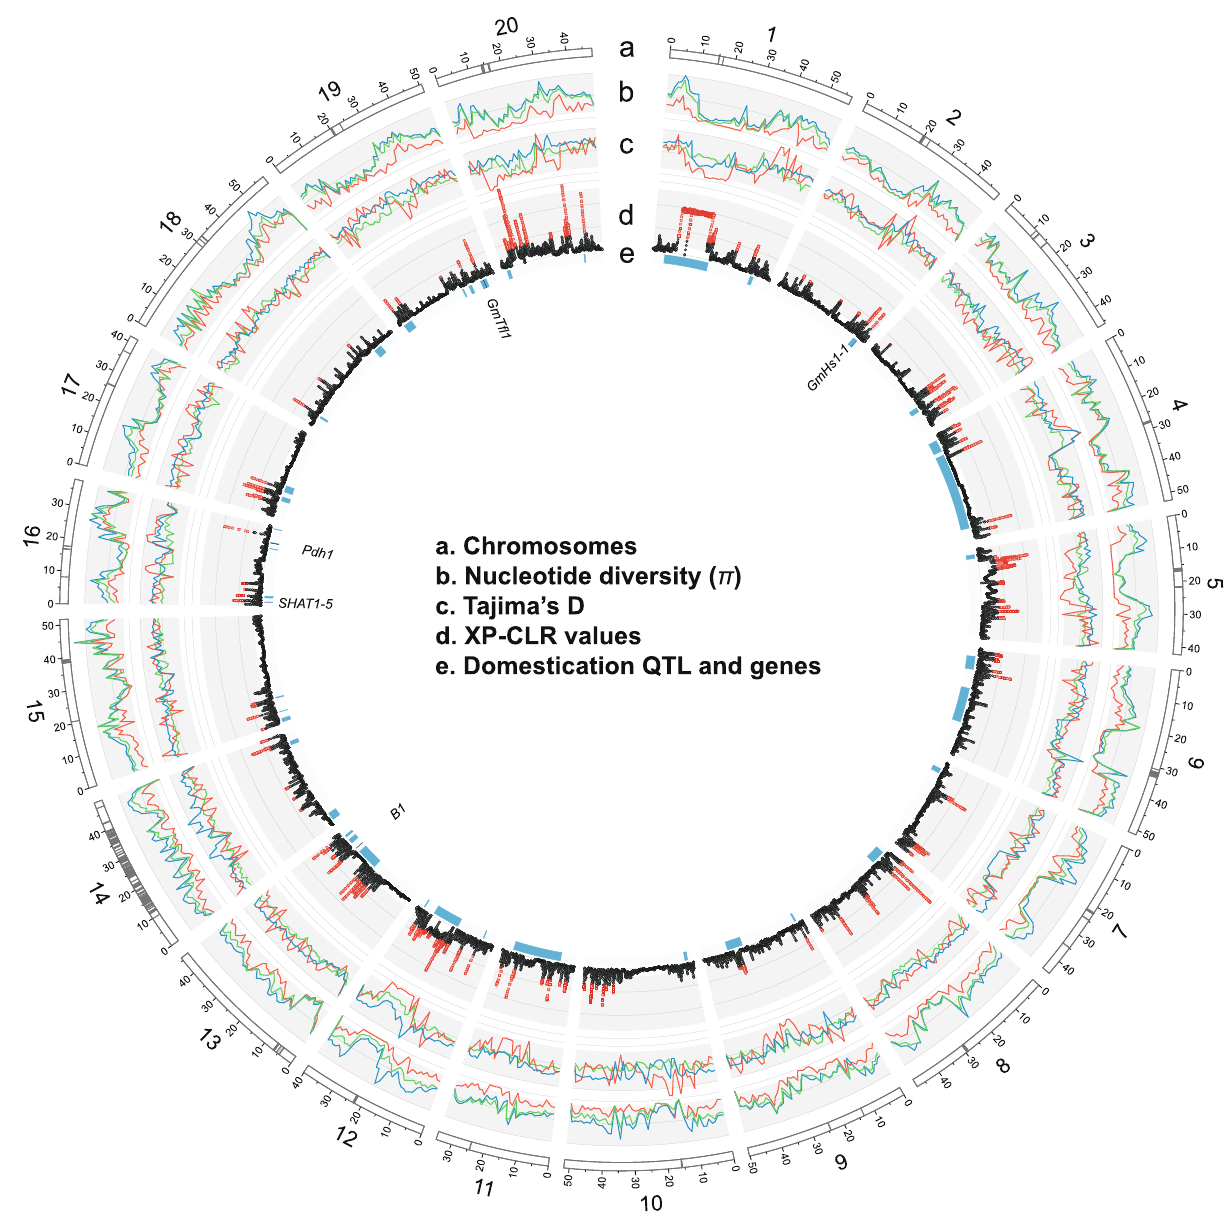
Fig. 3 Genomic landscape of selection signals for domestication in soybean. Chromosomes based on the Williams 82 reference genome sequence v. Wm82.a2.v1 (a). Centromere repeat regions are indicated by gray bands. Nucleotide diversity ( π ) in 1 Mb windows for each soybean subpopulation (red = G. max , dark blue = G. soja , green = hybrid) (b). Tajima ’ s D for each soybean subpopulation (red = G. max , dark blue = G. soja , green = hybrid) (c). Distribution of genome-wide likelihood (XP-CLR) values for selection during domestication (d). Plot is based on XP-CLR scores of 100-kb block with 10-kb sliding windows. Domestication quantitative trait loci (QTL) and genes on chromosomes as detected in a large mapping population Williams 82 × PI 479752 33 (QTL = blue bands and genes = dark blue bands) (e). Gene names are also